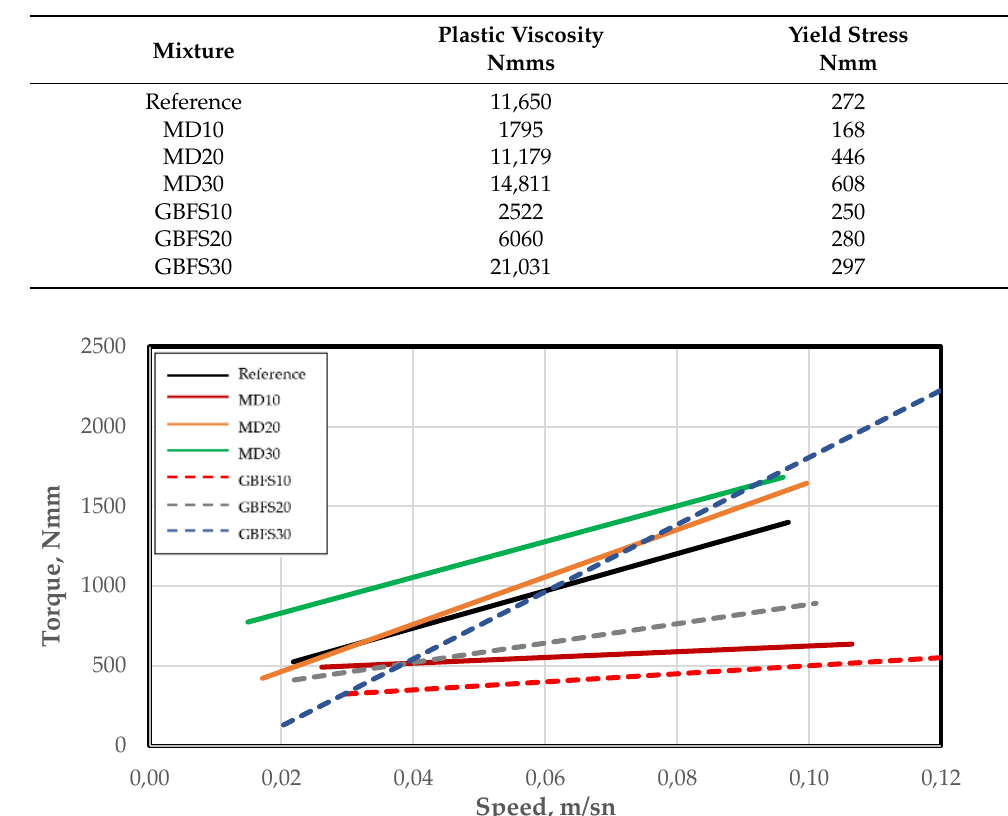
Figure 5. Rheometer analyses of the SCC mixtures.